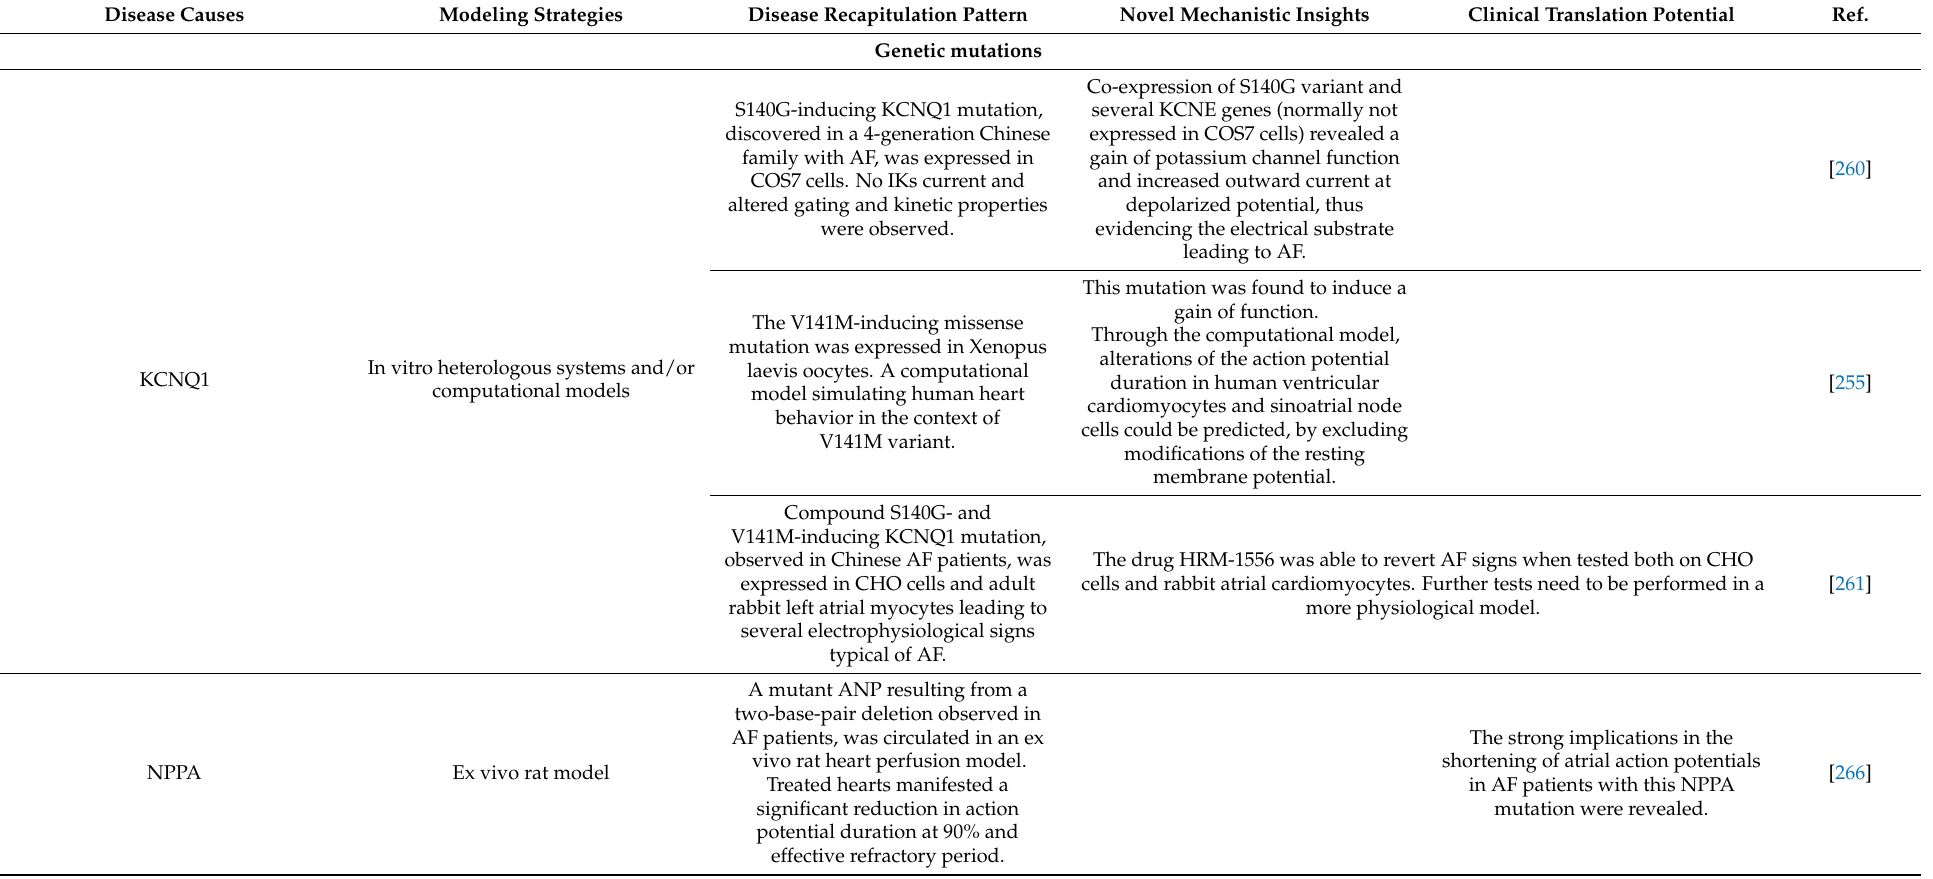
Table 3. Atrial fibrillation (AF): causes, modeling strategies, and their clinical